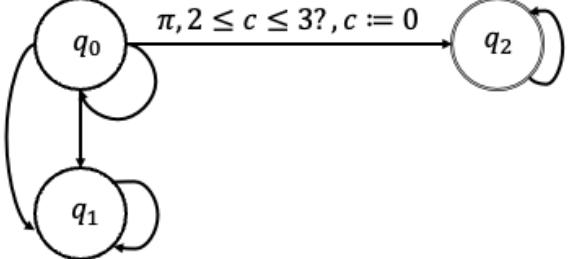
Figure 1. The deterministic timed Büchi automaton (DTBA) representing a metric interval temporal logic formula ϕ = (cid:51) [ 2,3 ] π . The states and transitions of the DTBA are represented by circles and arrows, respectively. The initial state of this DTBA is q 0 and the accepting state is q 2 . The formula ϕ can be satisfied if the DTBA reaches state q 2